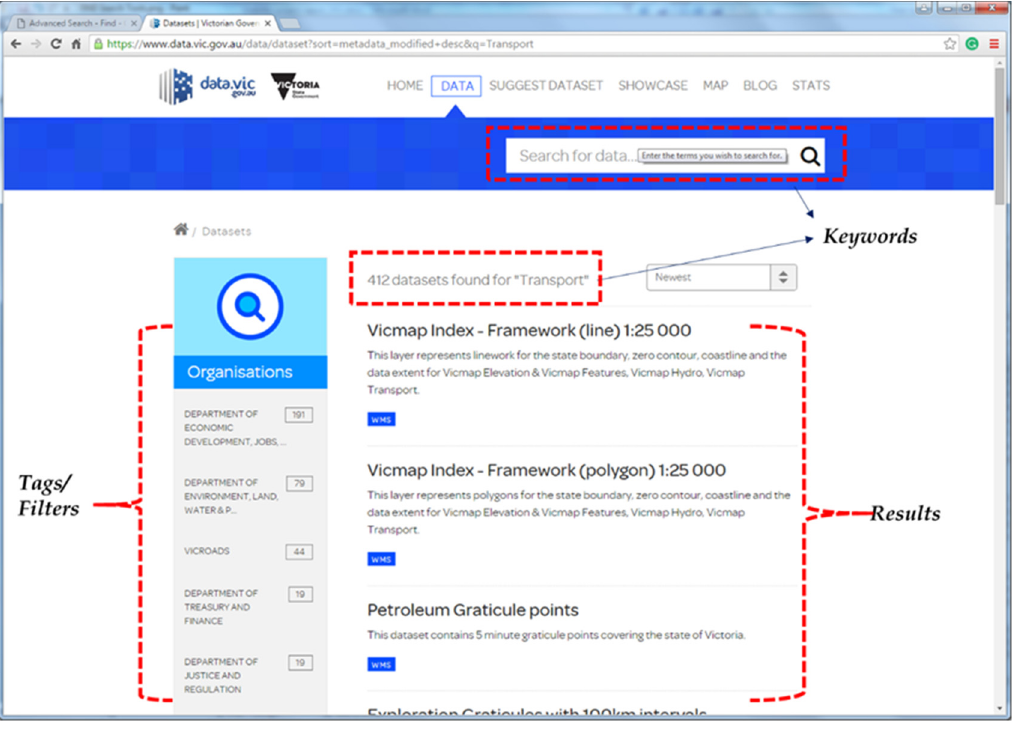
Figure 3. Problems identified with the Victoria Data Directory (VDD) systems in spatial data discovery.